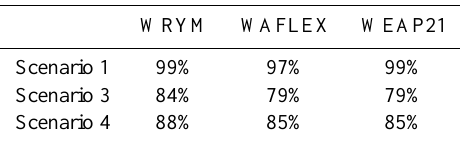
Table 8. Total level of satisfaction for all users in the Umbeluzi